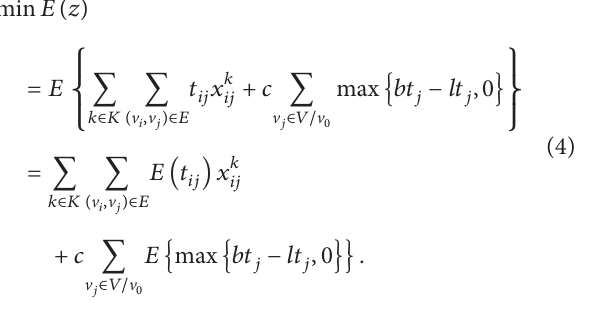
Figure 1 is an illustration of advancing 𝑙𝑡 𝑖 to 𝑙𝑡 󸀠 𝑖 for customer 𝑖